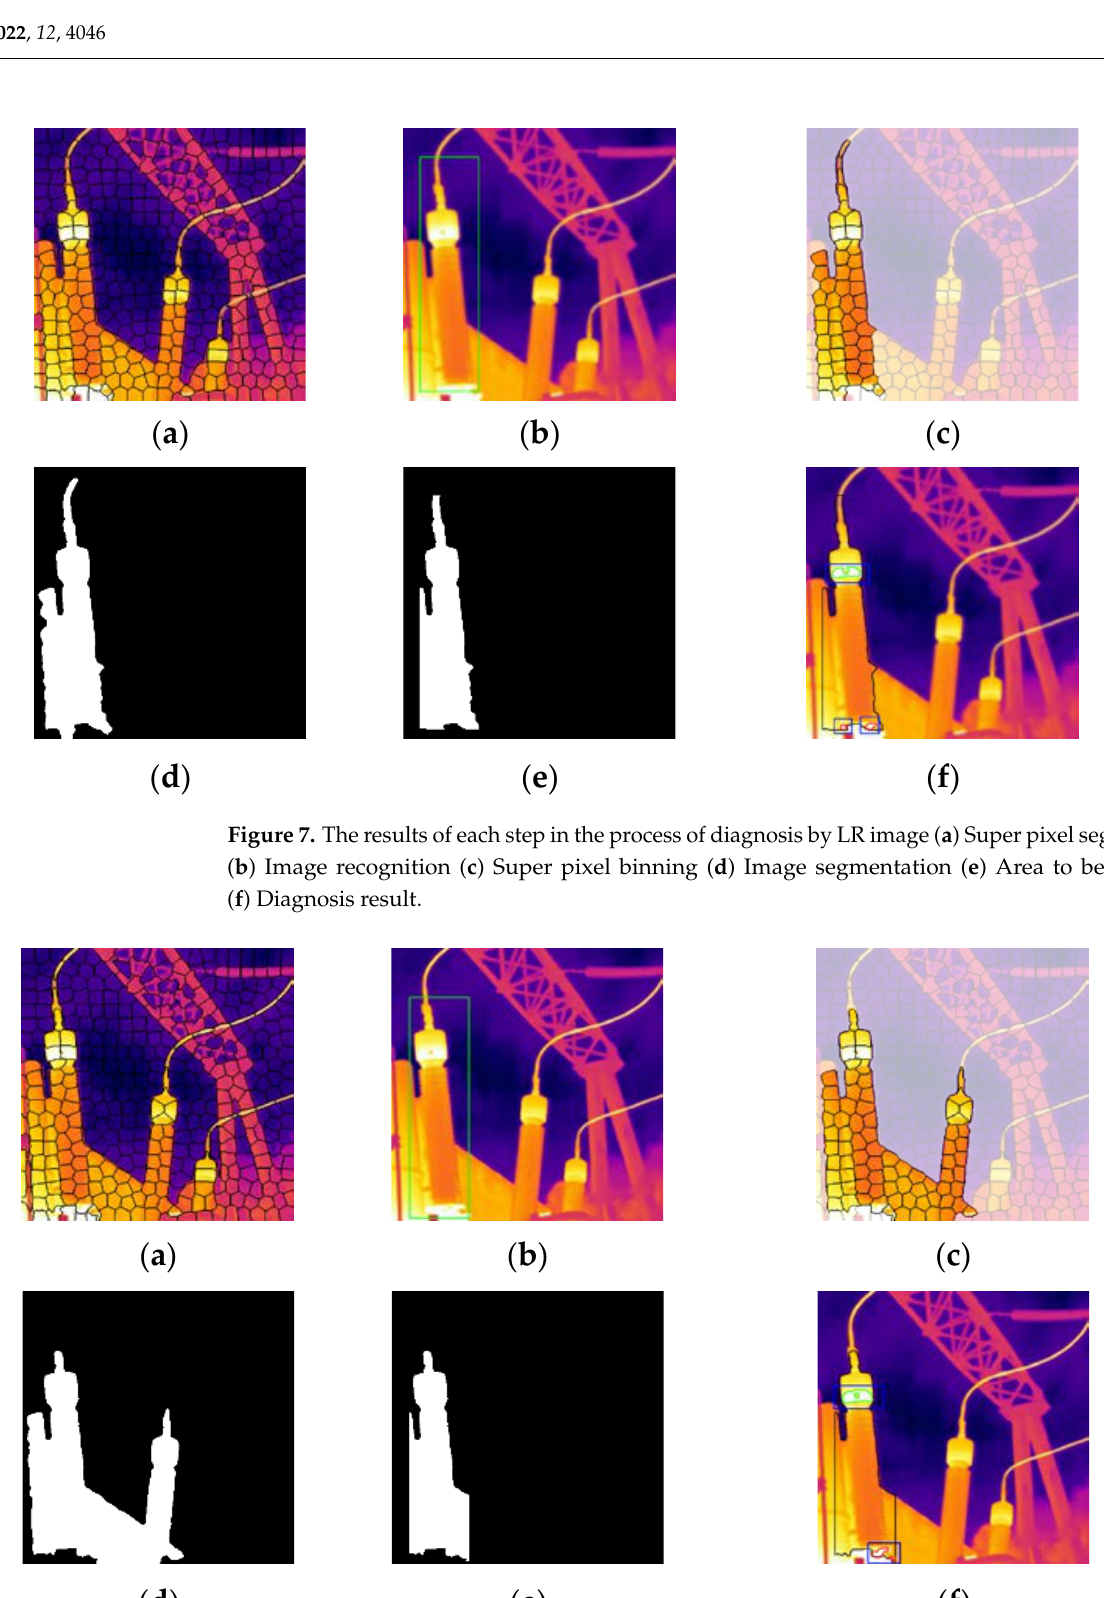
Figure 9. The results of each step in the process of diagnosis by Shao’ method ( a ) Super pixel segmentation ( b ) Image recognition ( c ) Super pixel binning ( d ) Image segmentation ( e ) Area to be inspected ( f ) Diagnosis result. Figure 10. The results of each step in the process of diagnosis by Li’s method ( a ) Super pixel segmentation ( b ) Image recognition ( c ) Super pixel binning ( d ) Image segmentation ( e ) Area to be inspected ( f ) Diagnosis result.